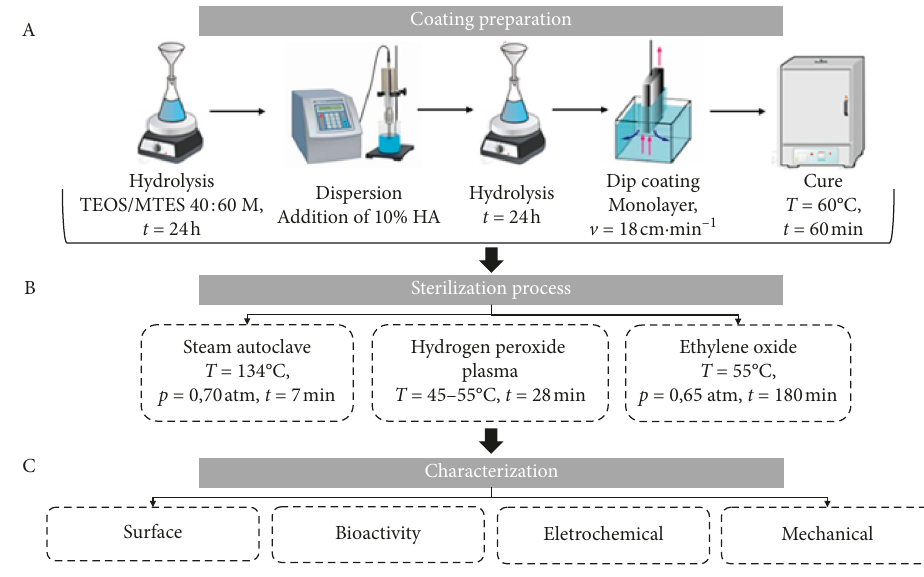
Figure 1: Flowchart of the development stages of this